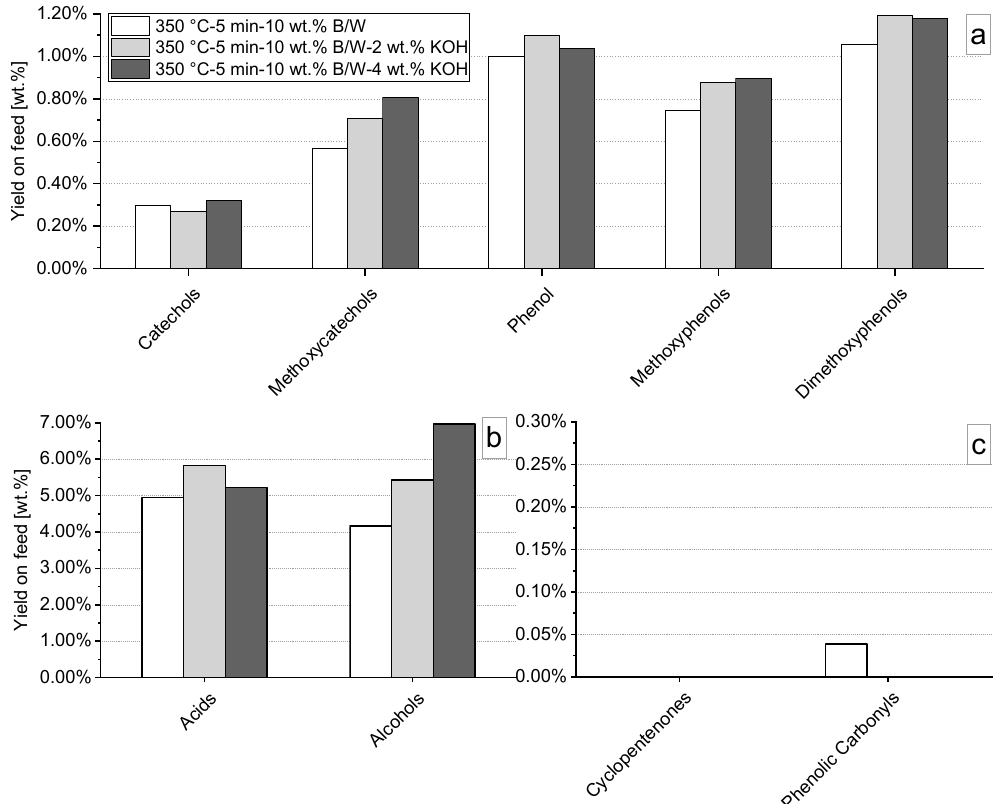
Figure 9. Effect of base catalyzed reactions increasing KOH to LRS ratio from 2 wt. % to 4 wt. % on yields of quantified compounds: (a) phenolics, (b) acids, and alcohols, (c) phenolic carbonyls and cyclopentenones. When no graph column is depicted, the concentration was below quantification limits.